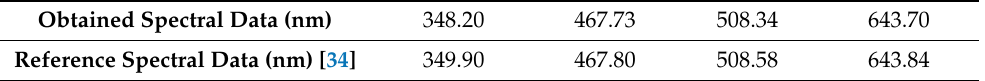
Table 3. Emission spectral lines of the plasma of the CdS target during the deposition.